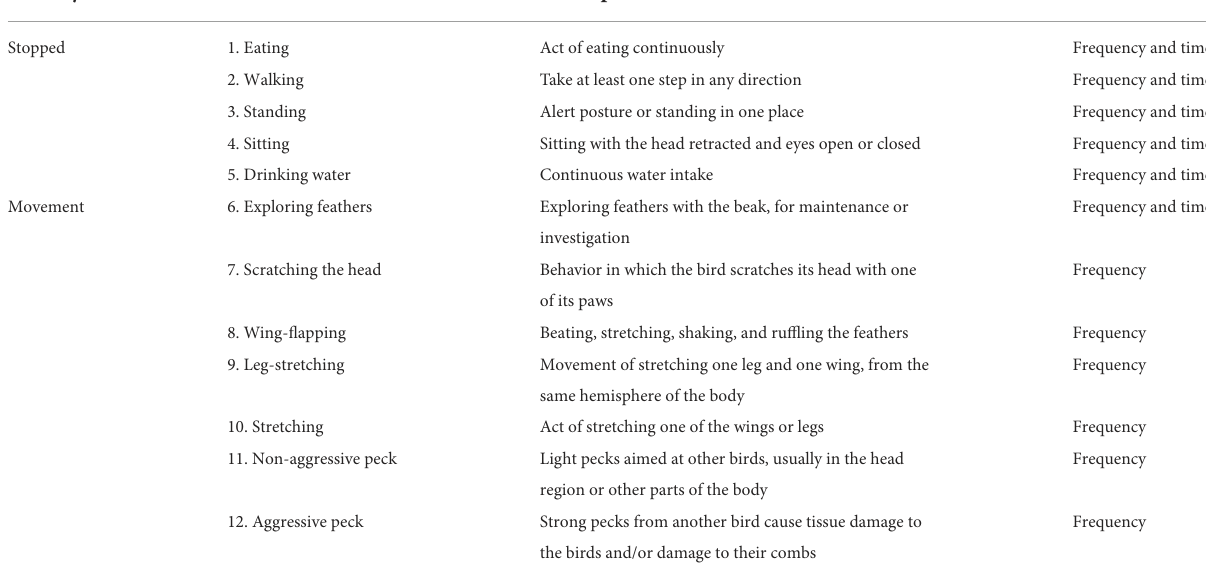
TABLE 1 Behavioral ethogram for laying hens in cage system.